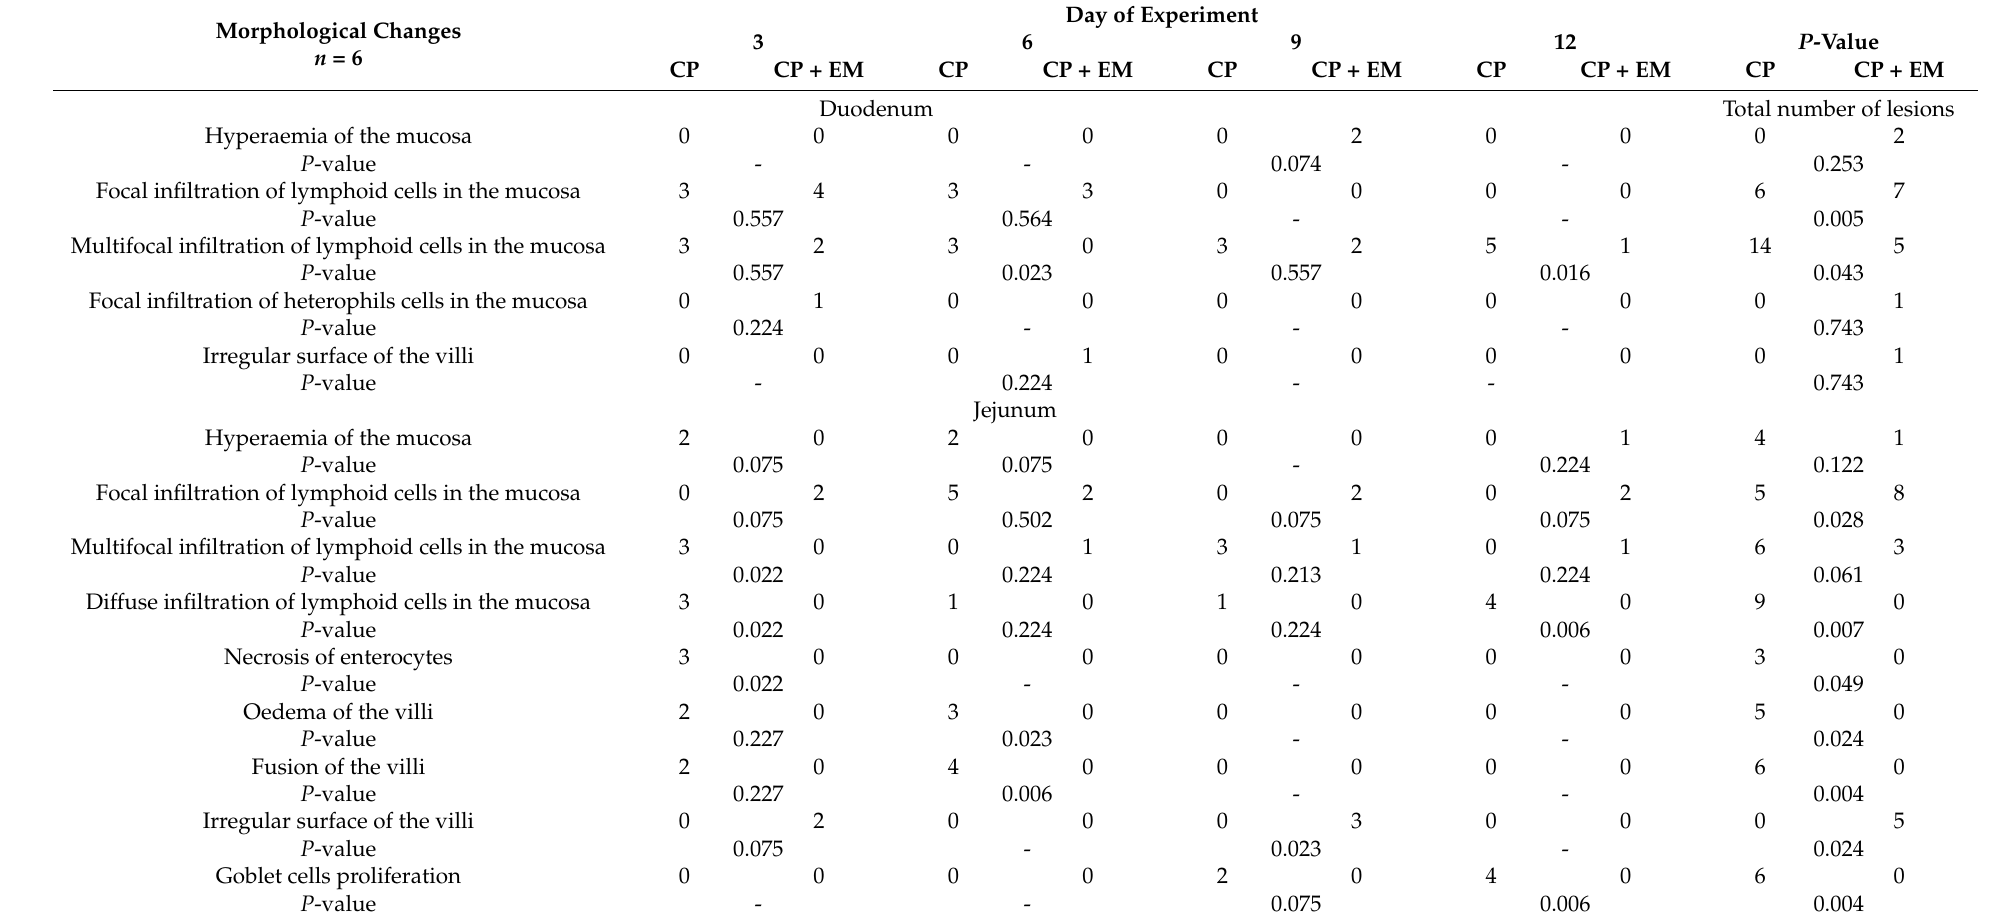
Table 1. Effect of EM supplementation on morphological lesions in the alimentary track in quails challenged with C.